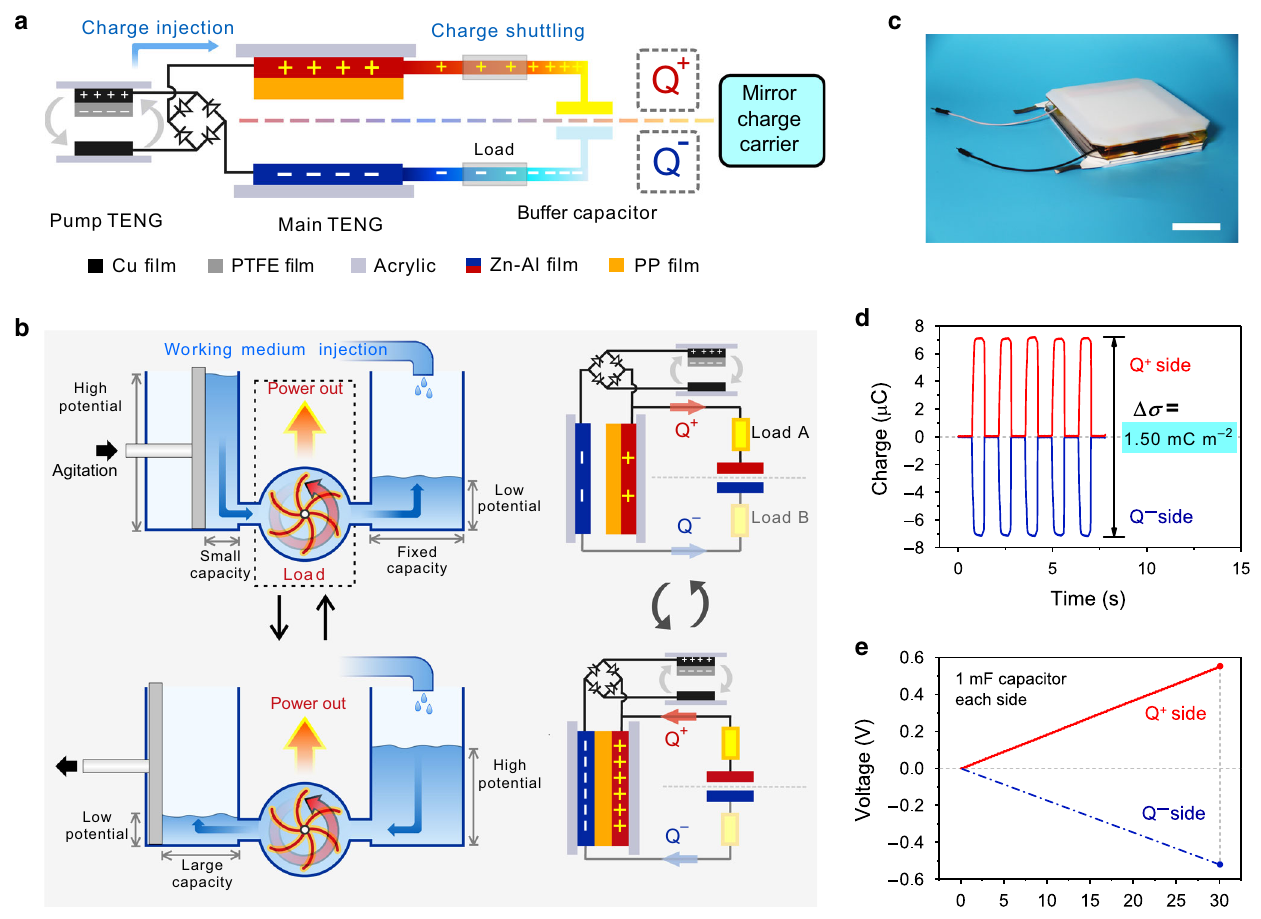
Fig. 1 Device structure and working principle. a Schematic illustration of charge shuttling. b Working process of the charge-shuttling-based triboelectric nanogenerator (CS-TENG) and an analogical model based on hydropower turbine. c Photograph of the as-fabricated main triboelectric nanogenerator (TENG) and pump TENG. Scale bar, 4 cm. d High output charge density realized in this work restricted by a Zener diode. e Demonstration of simultaneously charging two large capacitors. Source data are provided as a Source Data fi